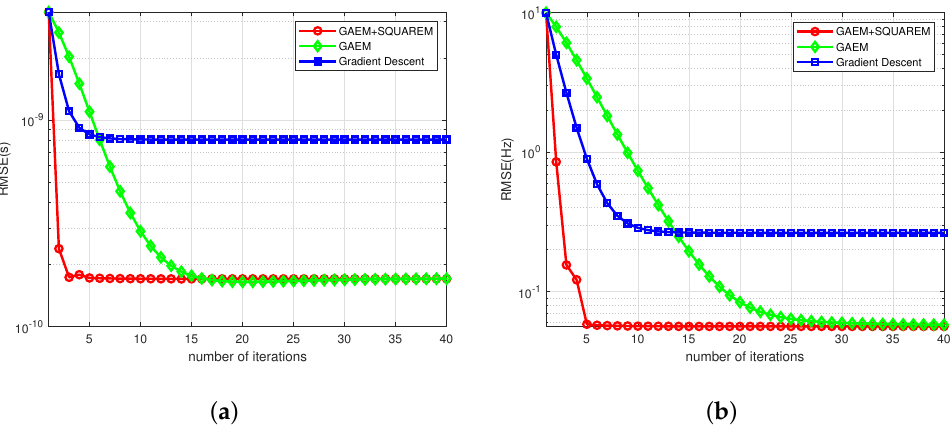
Figure 6. Estimation results for proposed GAEM and gradient descent method based on traditional maximum likelihood (ML) [34] in the presence of target echo superimposed. ( a ) Root mean square error (RMSE) for the echo delay estimation, ( b ) RMSE for the echo Doppler estimation. The line with square markers represents the echo delay estimate only using